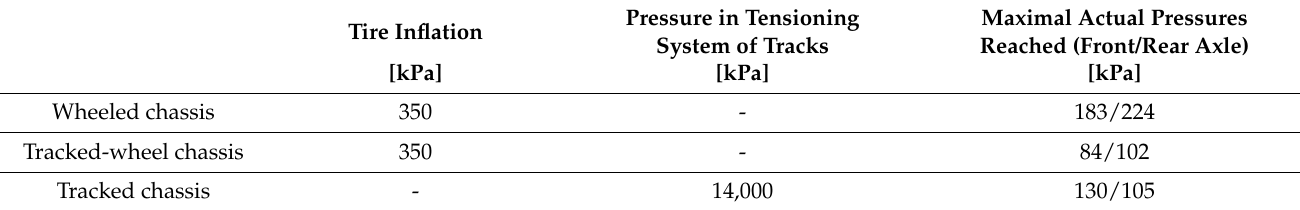
Table 4. Actual pressures of the three loaded chassis variants at a soil profile depth of 15 cm when driving on a layer of logging